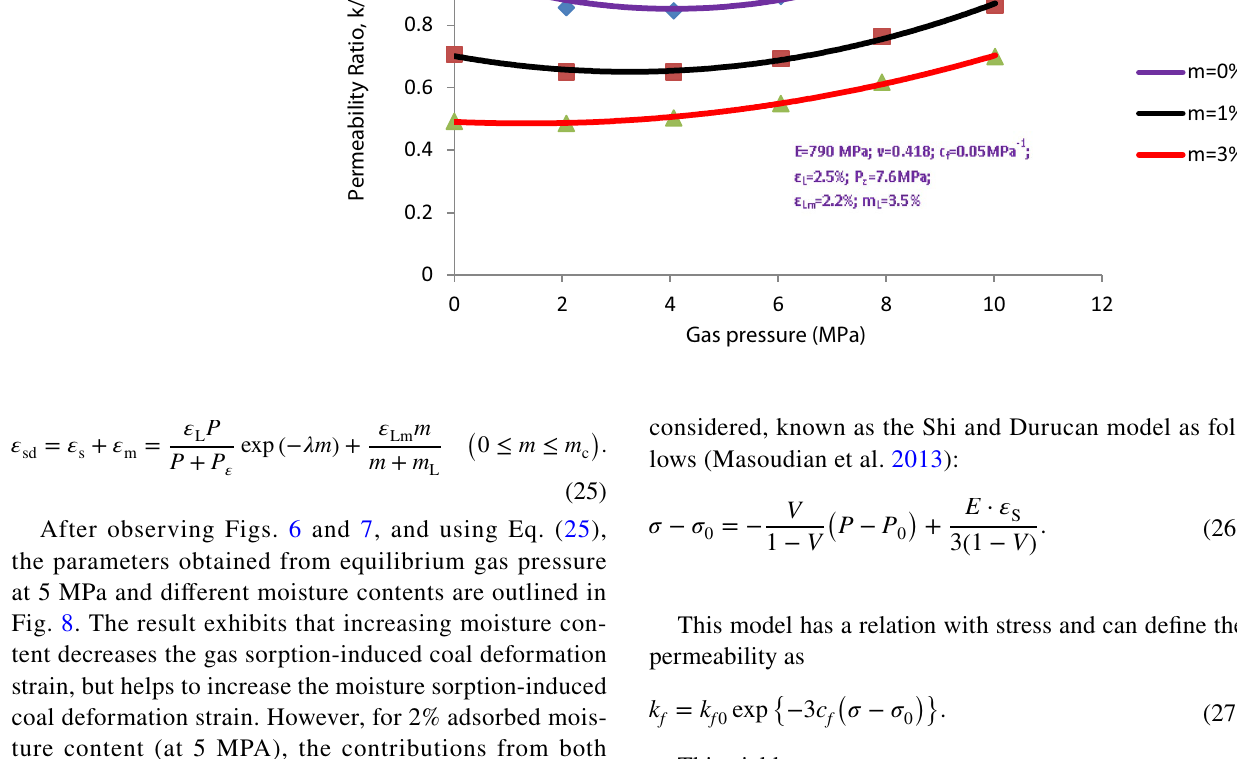
Fig. 9 Variation of coal perme- ability as a function of gas pres- sure under the effect of moisture